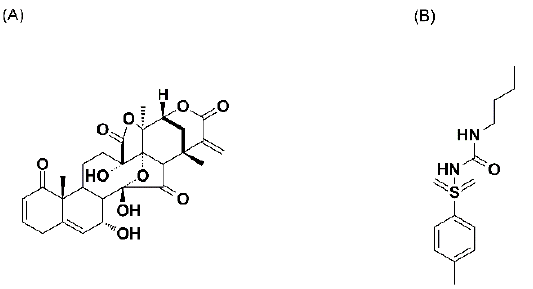
Figure 1. The chemical structures of ( A ) physalin A and ( B ) tolbutamide